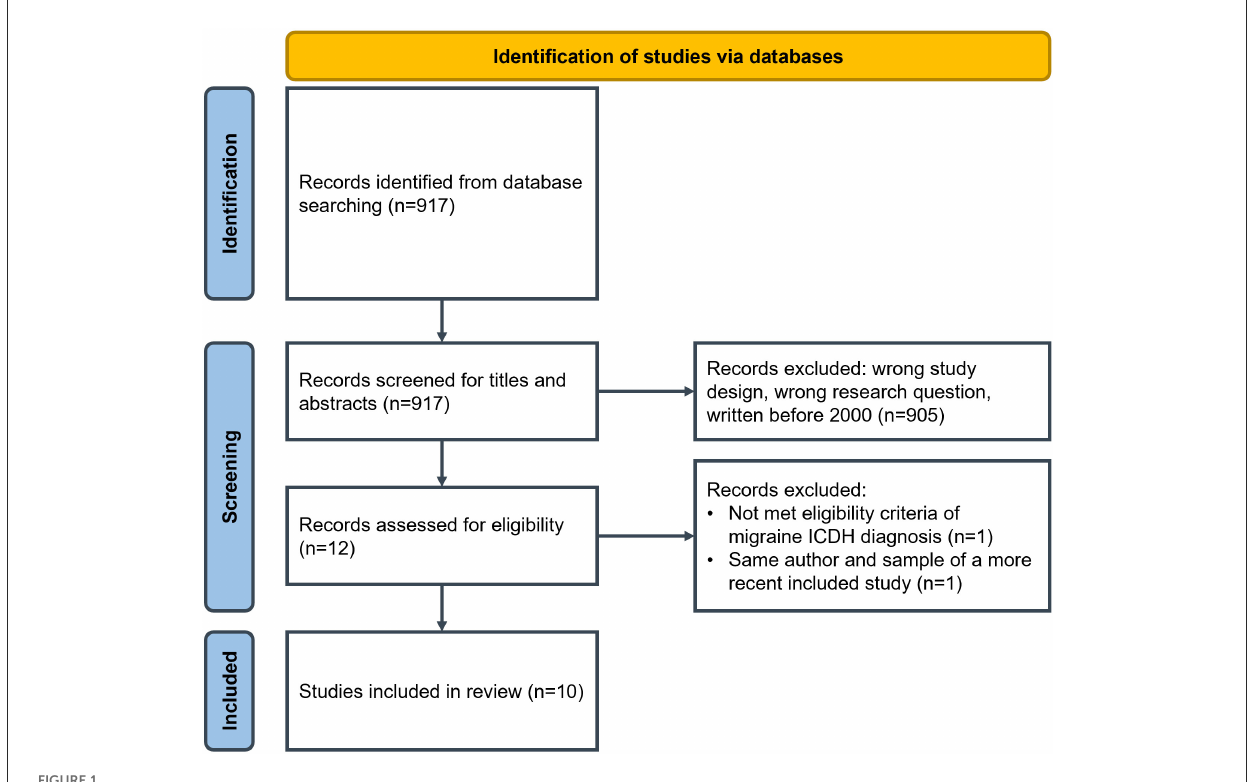
FIGURE1 PRISMA 2020 flow diagram.